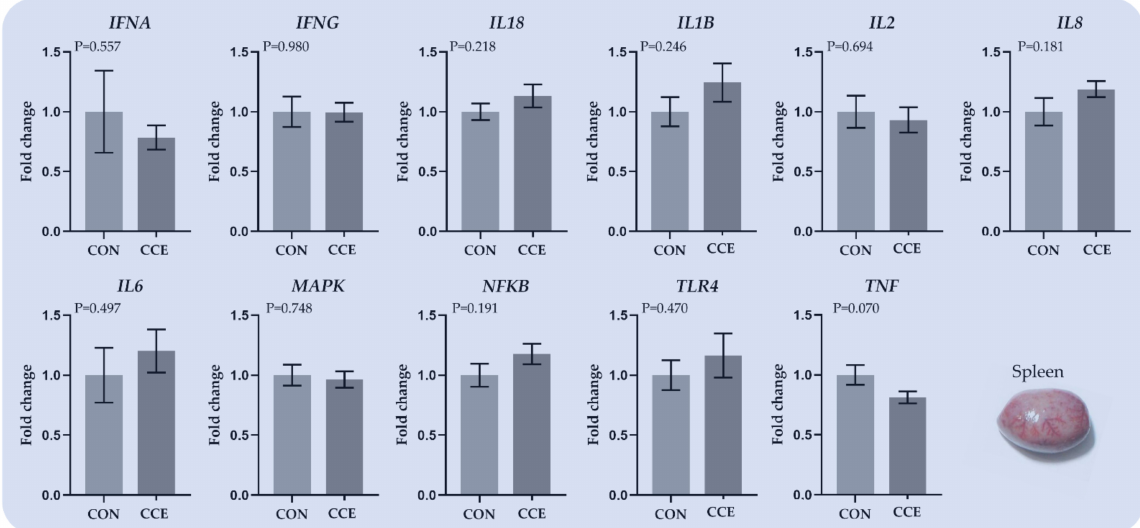
Figure 7. The mean and standard error of means (SEM) of relative transcript levels as fold changes of several genes involved in the immune system in the spleen of broilers fed the two experimental diets (Control; CON and carotenoid extract from Citrus reticulata included in soluble starch; CCE) at 42 days. INFA: Translation initiation factor IF-1, INFG: Interferon-gamma, IL18: Interleukin 18, IL1B: Interleukin 1 Beta, IL2: Interleukin 2, IL8: C-X-C Motif Chemokine Ligand 8, IL6: Interleukin 6, MAPK: Mitogen-activated protein kinase, NFKB: Nuclear factor-kappa B, TLR4: Toll-like receptors 4, and TNF: Tumor necrosis factor